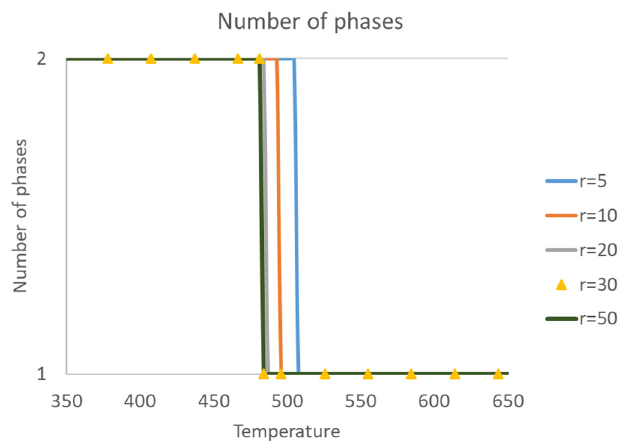
Figure 4. Number of phases at equilibrium changing with temperature under the constant overall mole concentration as 10 mol/m 3.